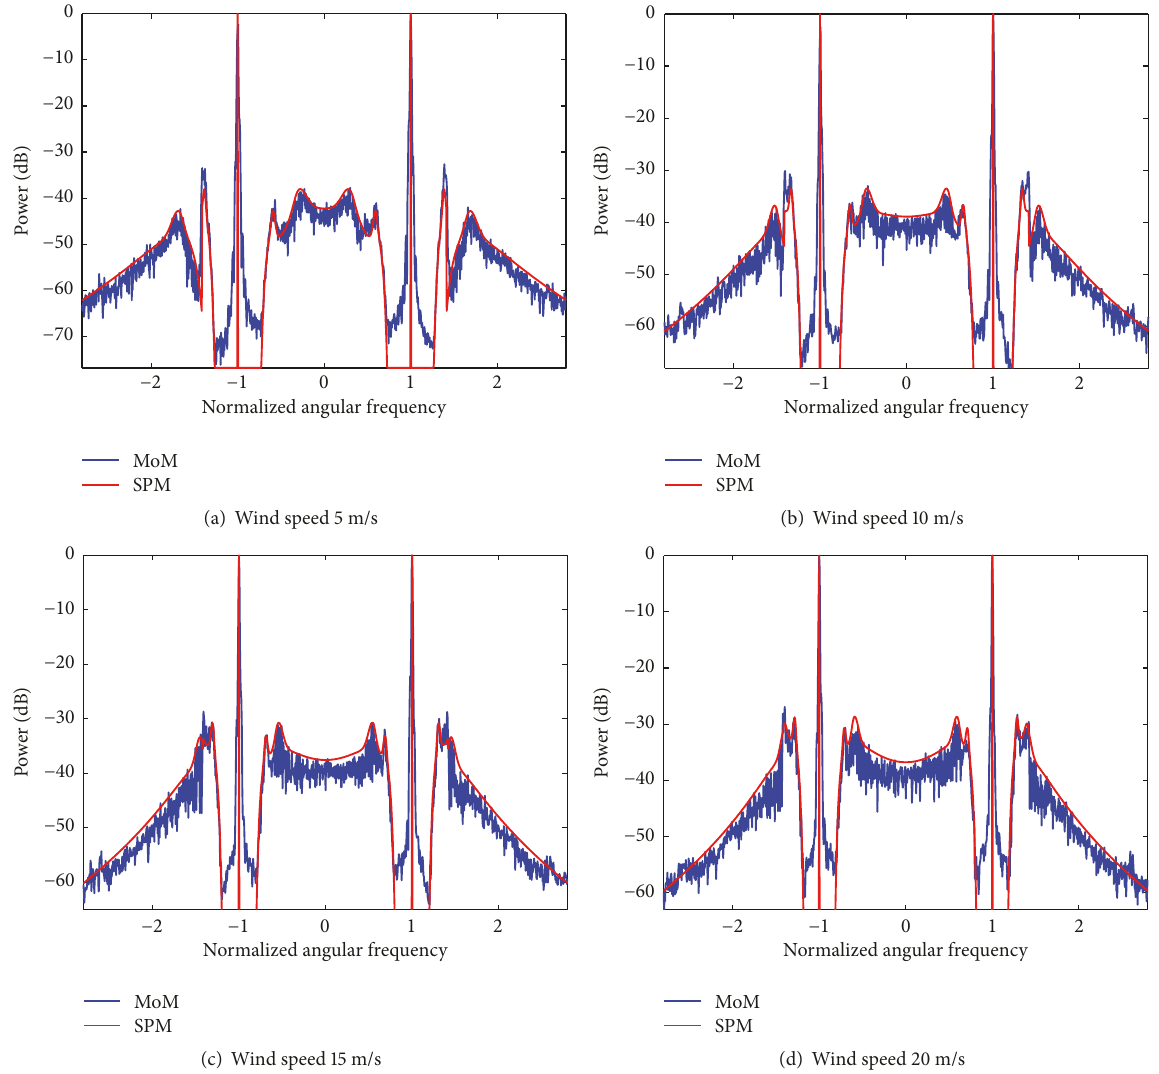
Figure 6: Comparison of Doppler spectrum between the numerical simulation and the SPM in different sea states. The frequency is 10 MHz and the sea surfaces are linear. The Doppler frequency is normalized by the Bragg frequency 𝜔 𝑏 , and the spectral intensity is normalized by Bragg